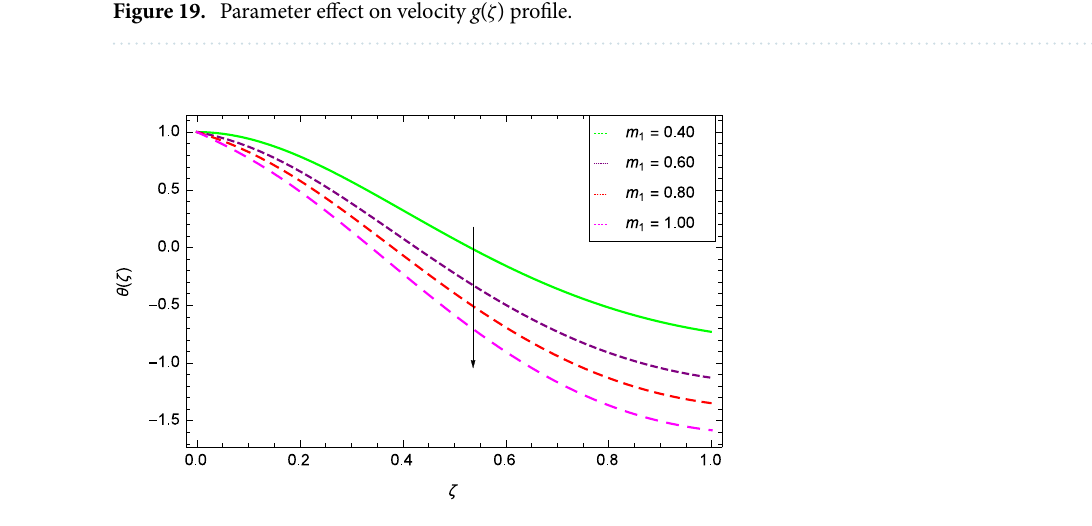
Figure 20. Parameter effect on heat transfer θ ( ζ ) profile.